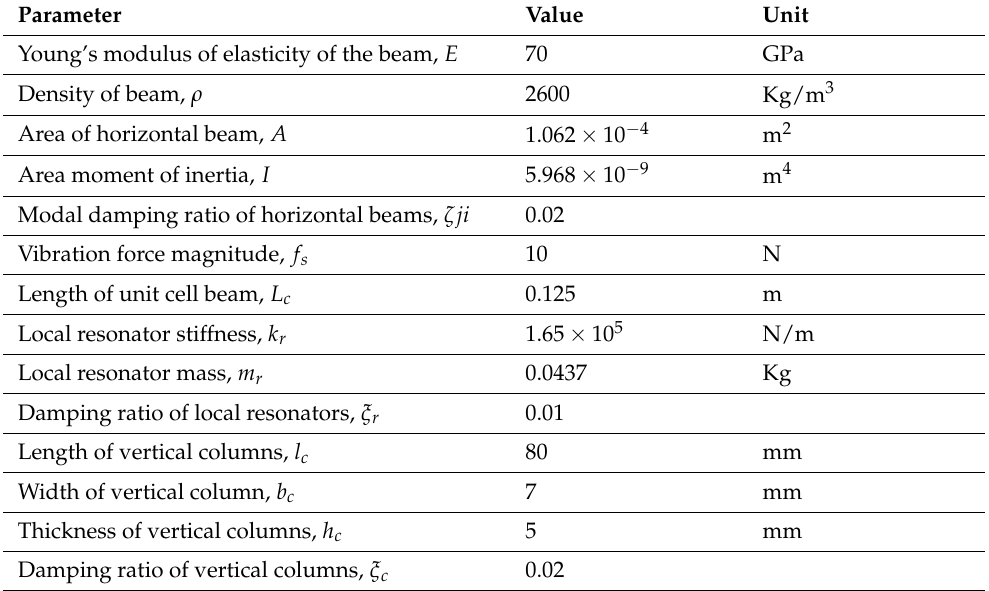
Table 1. Model design parameters of the single-beam metamaterial structure and the layered-beam metamaterial structure.